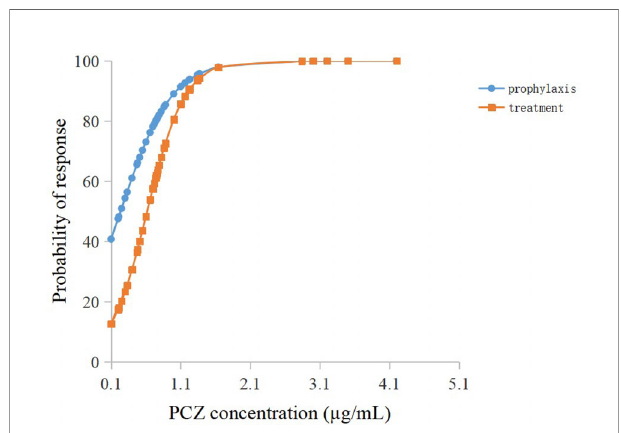
FIGURE 4 | Logistic regression model showing posaconazole trough concentration predicting the probability of successful clinical response of prophylaxis and treatment.